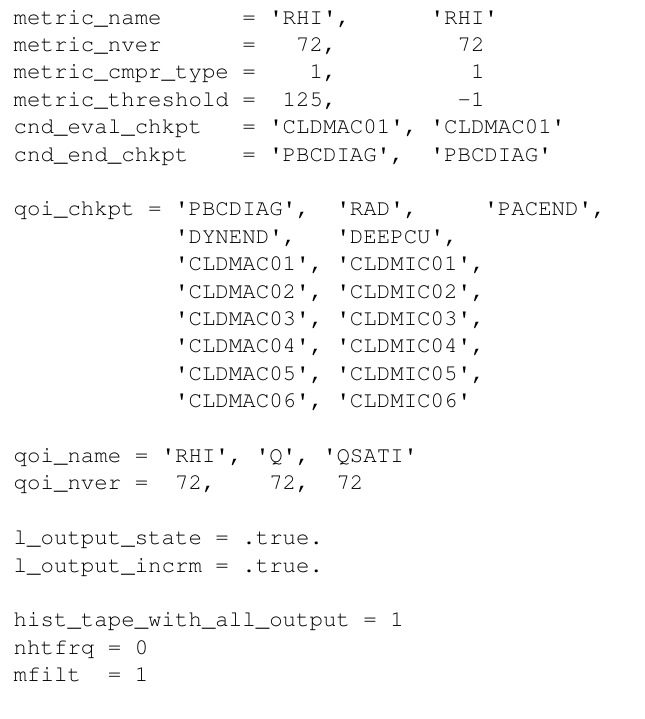
Table 4. Namelist variables pertaining to the new diagnostic tool used in the conditional RHI budget analysis presented in Sect. 6.3.